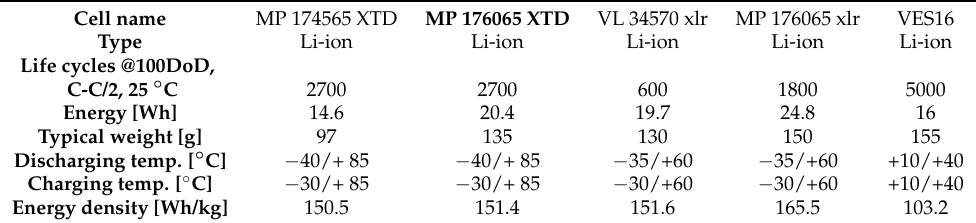
Table 5. Characteristics of investigated rechargeable battery cells.